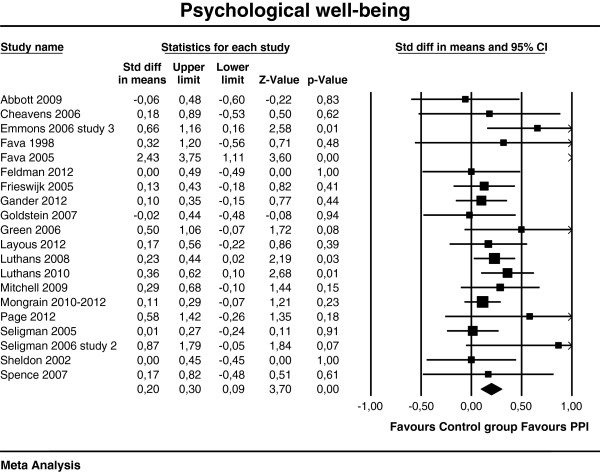
Post-test effects of positive psychology interventions on psychological well-being. The square boxes show effect size and sample size (the larger the box, the larger the sample size) in each study, and the line the 95% confidence interval. The diamond reflects the pooled effect size and the width of the 95% confidence interval.